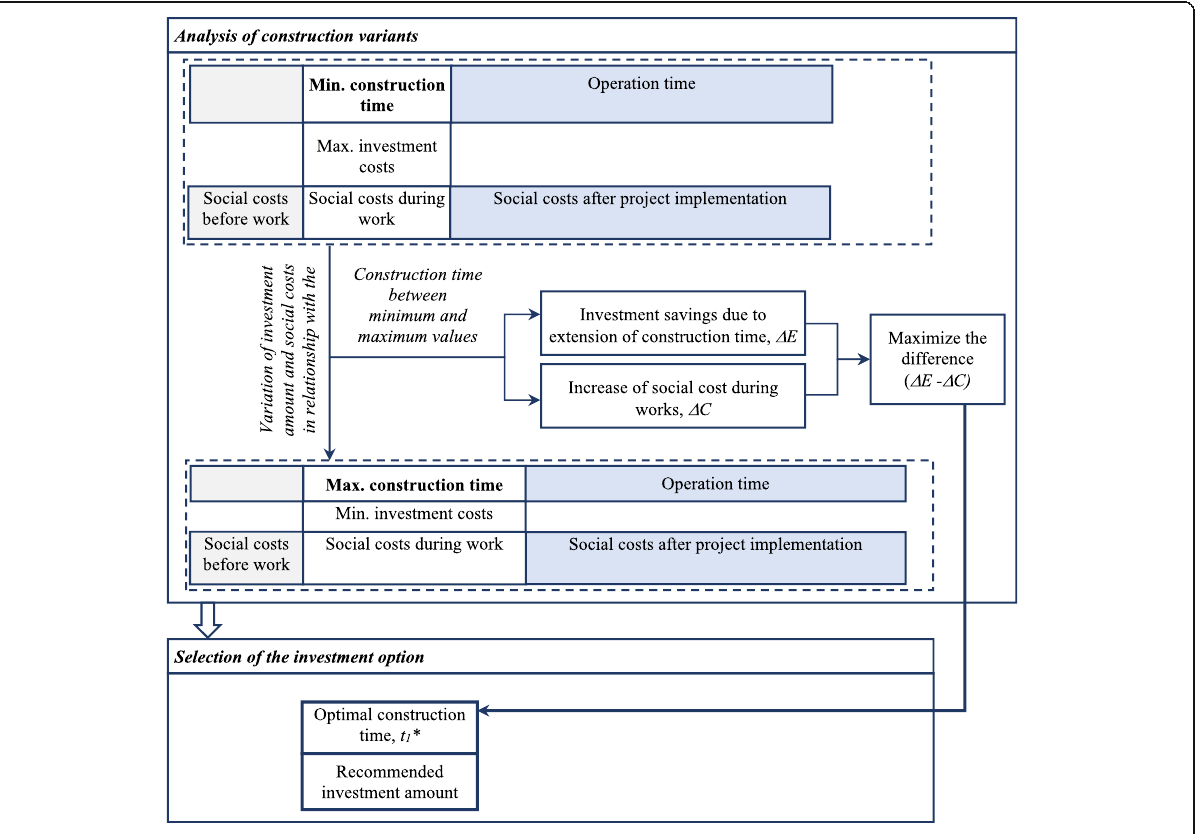
Fig. 3 The structure of the model for selection of the most appropriate investment